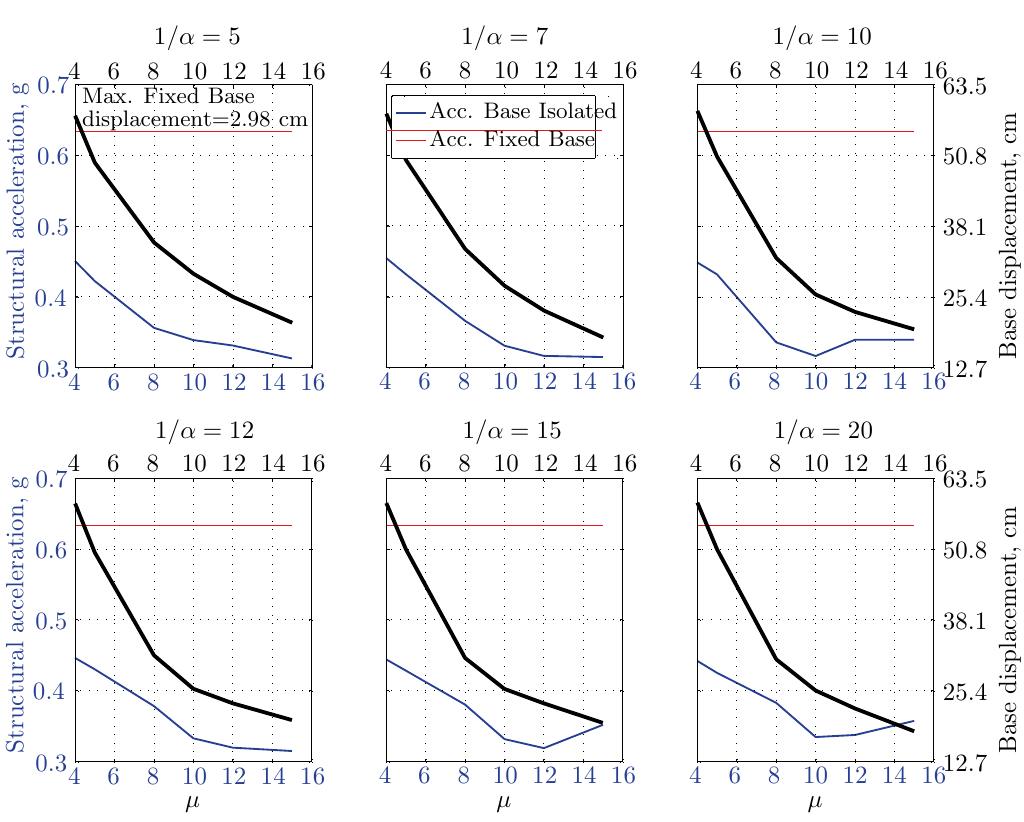
Figure 14. Peak responses of BI-structures subjected to El Centro